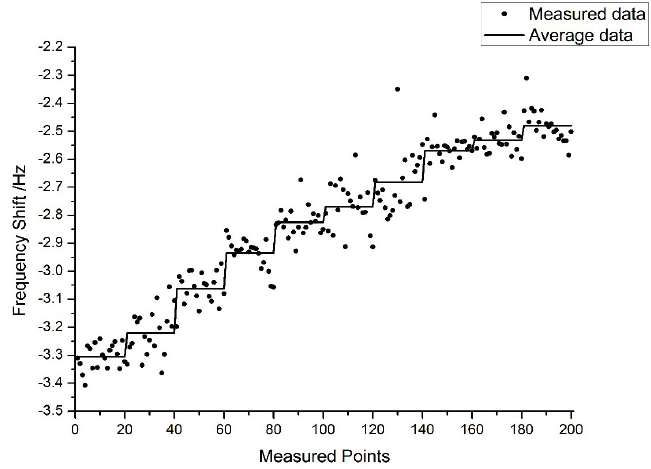
Figure 11. The resolution of an Akiyama probe (2 nm